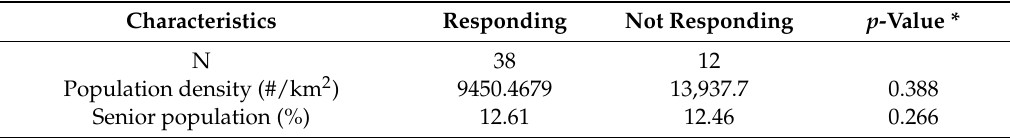
Table 1. Differences between responding jurisdictions and non-responding